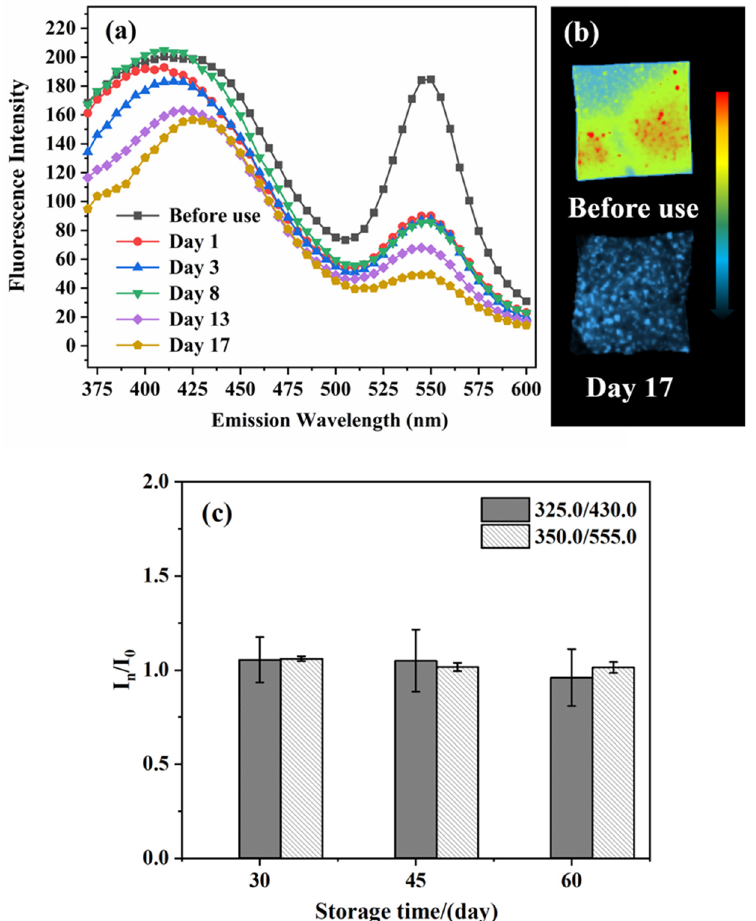
Figure 6. ( a ) Fluorescence emission spectra (excitation at 340 nm) of RhB@MOF-5 composite films of pork samples stored at 4 °C. ( b ) Fluorescence image of RhB@MOF-5 composite film before and after pork spoilage (excitation light of 530 nm). ( c ) Storage stability of RhB@MOF-5 composite film at 4 °C in dark conditions.